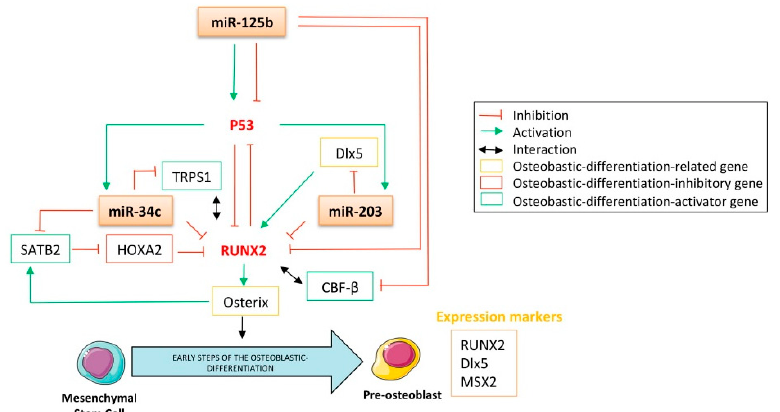
Figure 3. The direct targeting of RUNX2 and Dlx5 by the p53-related miRNAs involved them in the control of the early steps of the osteoblastic di ff erentiation. CBF- β : core-binding factor β ; MSX2: Msh homeobox 2; RUNX2: runt-related transcripion factor 2; SATB2: Special AT-rich sequence binding protein 2; TRPS1: Tricho-rhino-phalangeal syndrome